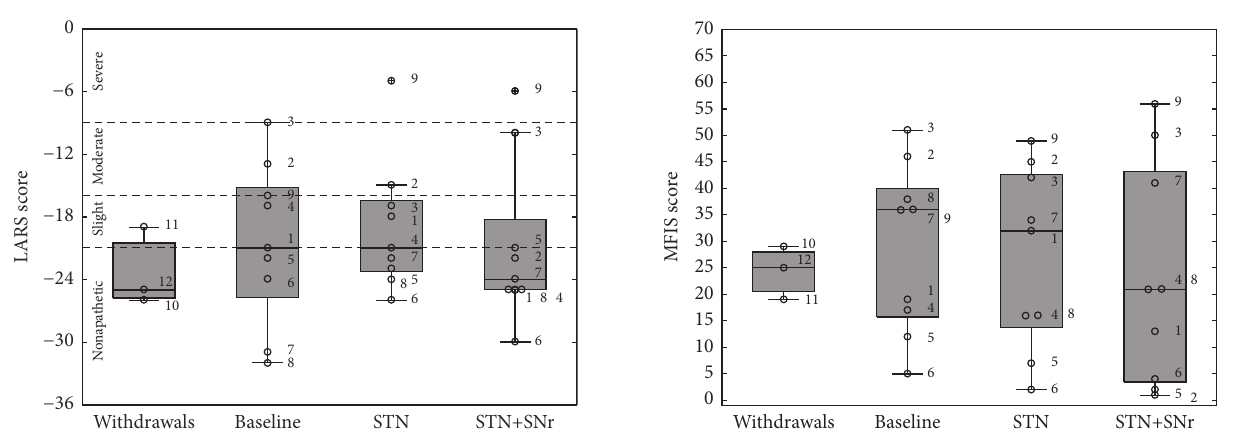
Figure 5: Boxplots of MFIS scores: the box plot depicted on the left represents the baseline values of the three patients who withdrew. The other three box plots represent the values of the 9 PD patients who have completed the study at the three experimental time points: (1) baseline, (2) STN alone, and (3) combined STN+SNr-DBS. The numbered circles represent the single patients as listed in Table